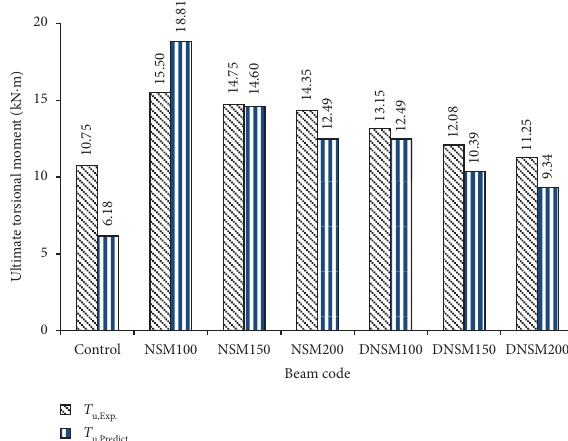
Figure 16: Experimental versus analytical ultimate torsional moments at each concrete